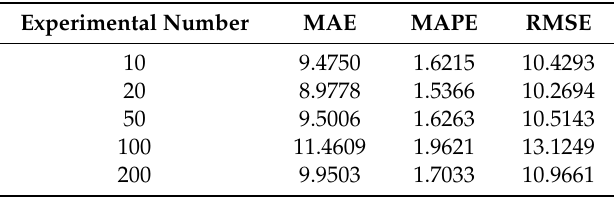
Table 4. Metrics of comparison experiments (Group 3).